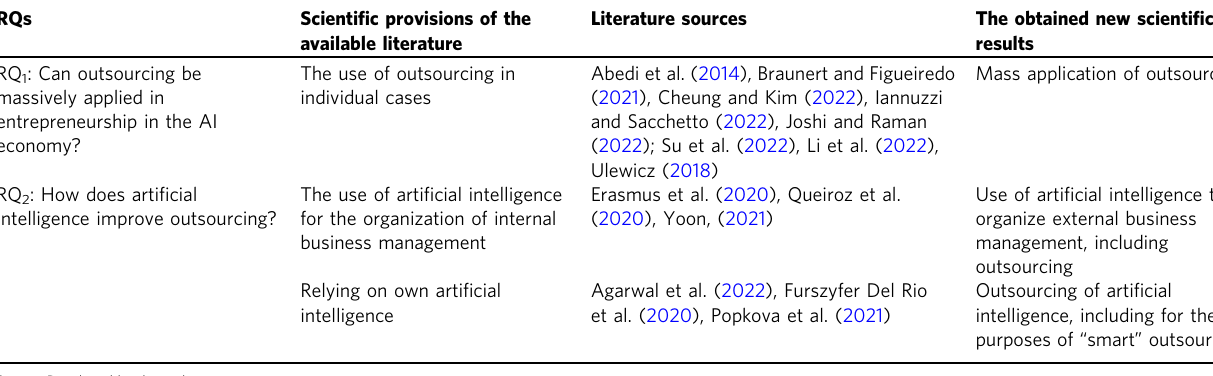
Table 3 Comparison of the obtained results with the existing literature.